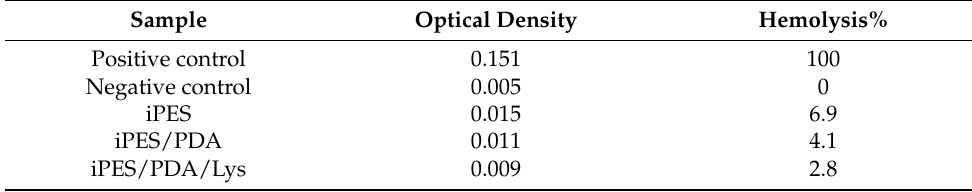
Table 2. Hemolysis rate of the membranes.